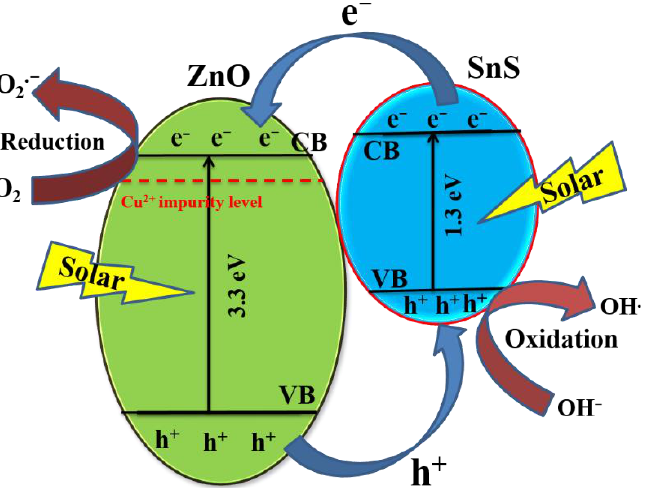
Figure 6. Photodegradation mechanism of MB dye using Cu 2+ -doped ZnO–SnS nanocomposites.